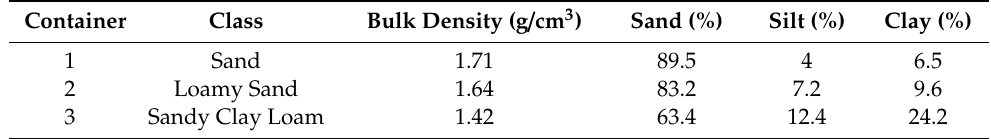
Table 1. Soil classification result for the laboratory